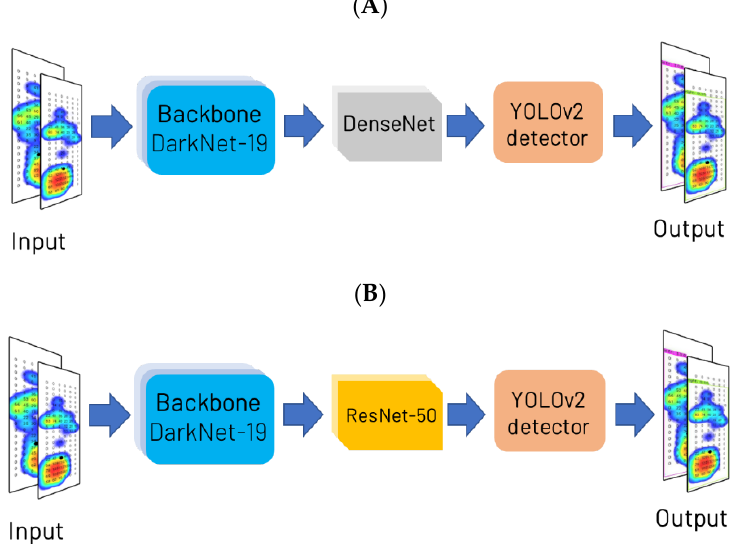
Figure 1. Illustration of object detection Network Architecture; ( A ) Residual Neural Network 50 (ResNet-50) network architecture. ( B ) Dense Convolutional Network (DenseNet) network architec- ture.